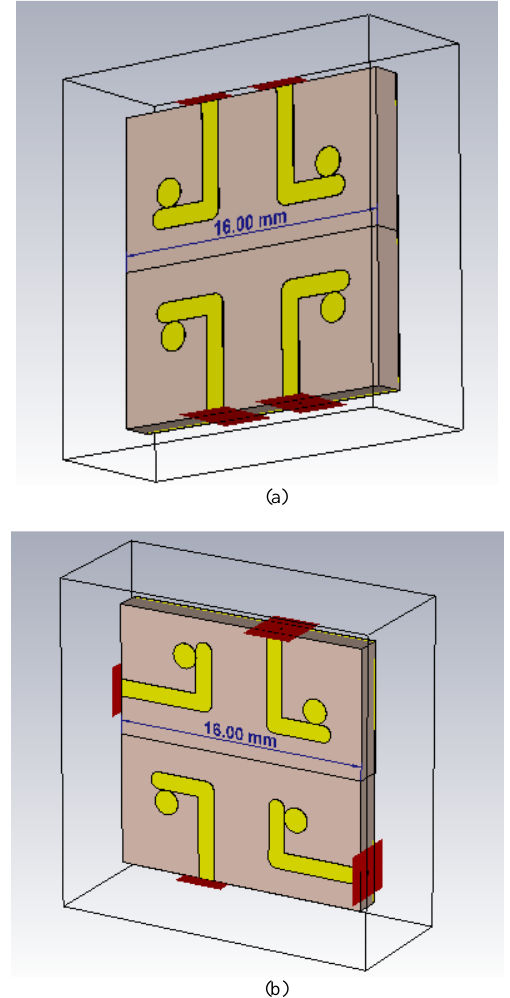
Fig.8. The proposed MIMO 2X2 antenna, (a) the first MIMO model and (b) the second MIMO